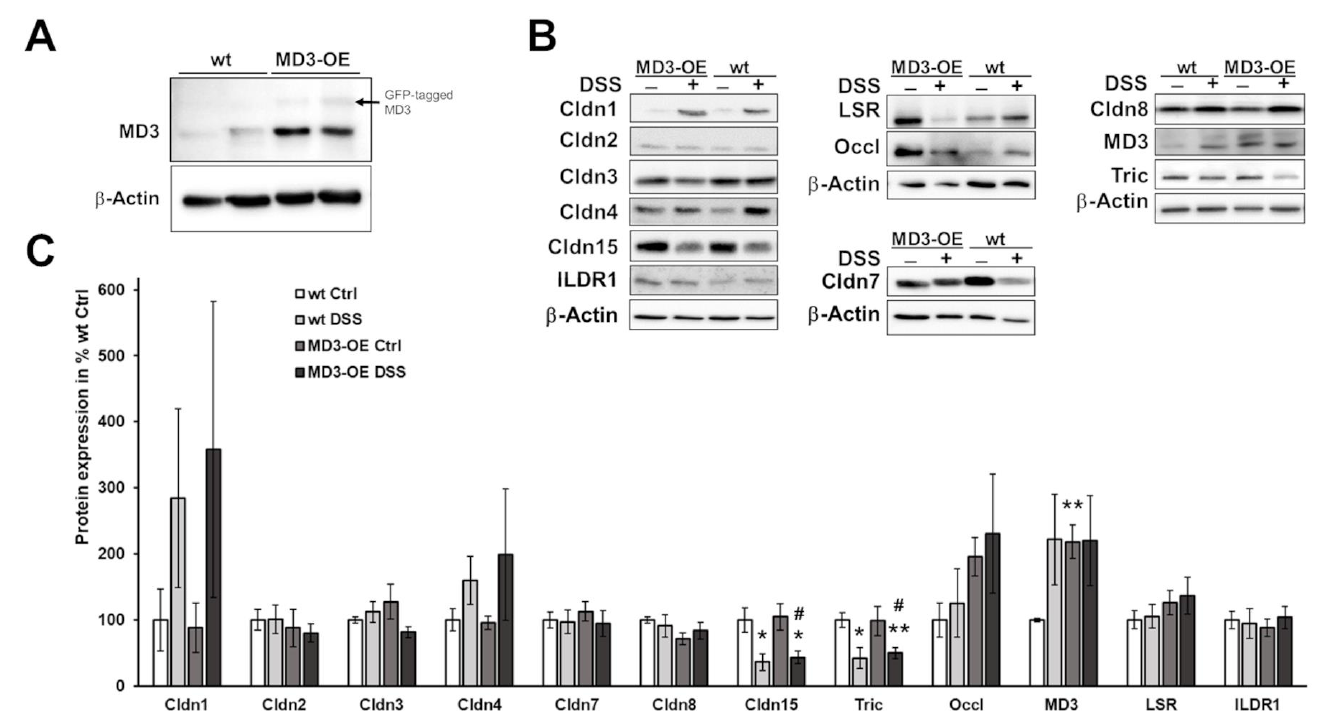
Figure 5. Expression of MD3 and other TJ proteins. ( A ). Representative Western blots for MD3 and β-actin of wt mice and MD3-OE intestinal tissue. In addition to the MD3 signal in MD3-OE, some GFP-tagged MD3 was detectable. However, as the MD3 contained its start codon in addition to the N-terminal tag, amounts of untagged MD3 occurred in MD3-OE. ( B ). Representative Western blots for MD3 and other TJ proteins of wt and MD3-OE under control conditions and under the influence of DSS with corresponding β-actin signals. ( C ). Densitometric analysis of TJ expression profiles in wt and MD3-OE mice under control conditions (Ctrl) and DSS-induced colitis ( n = 3–13; * p < 0.05; ** p < 0.01 compared to wt Ctrl; # p < 0.05 compared to MD3-OE Ctrl).